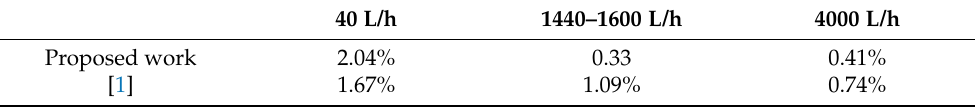
Table 5. Accuracy results